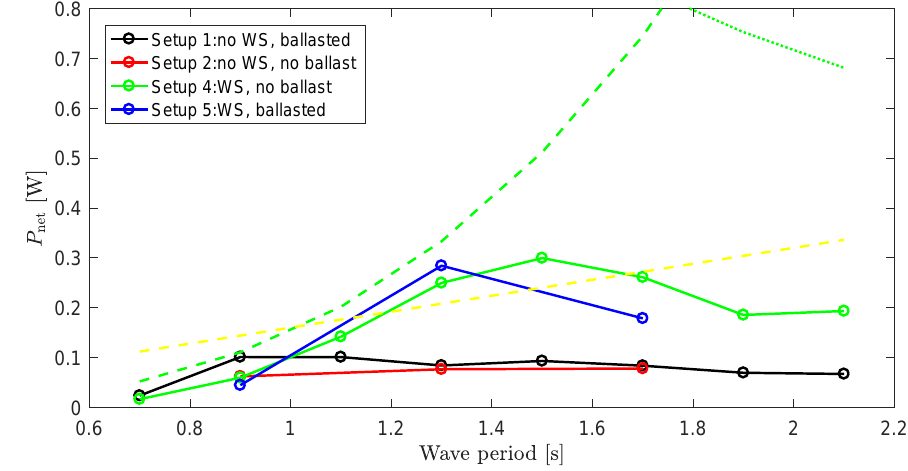
Figure 15. Average net absorbed power. Also shown are the upper theoretical limits for an axisymmetric heaving body (green, dashed) and Budal’s upper bound (green, dotted). The yellow dashed line shows the amount of power passing over a width equal to the buoy